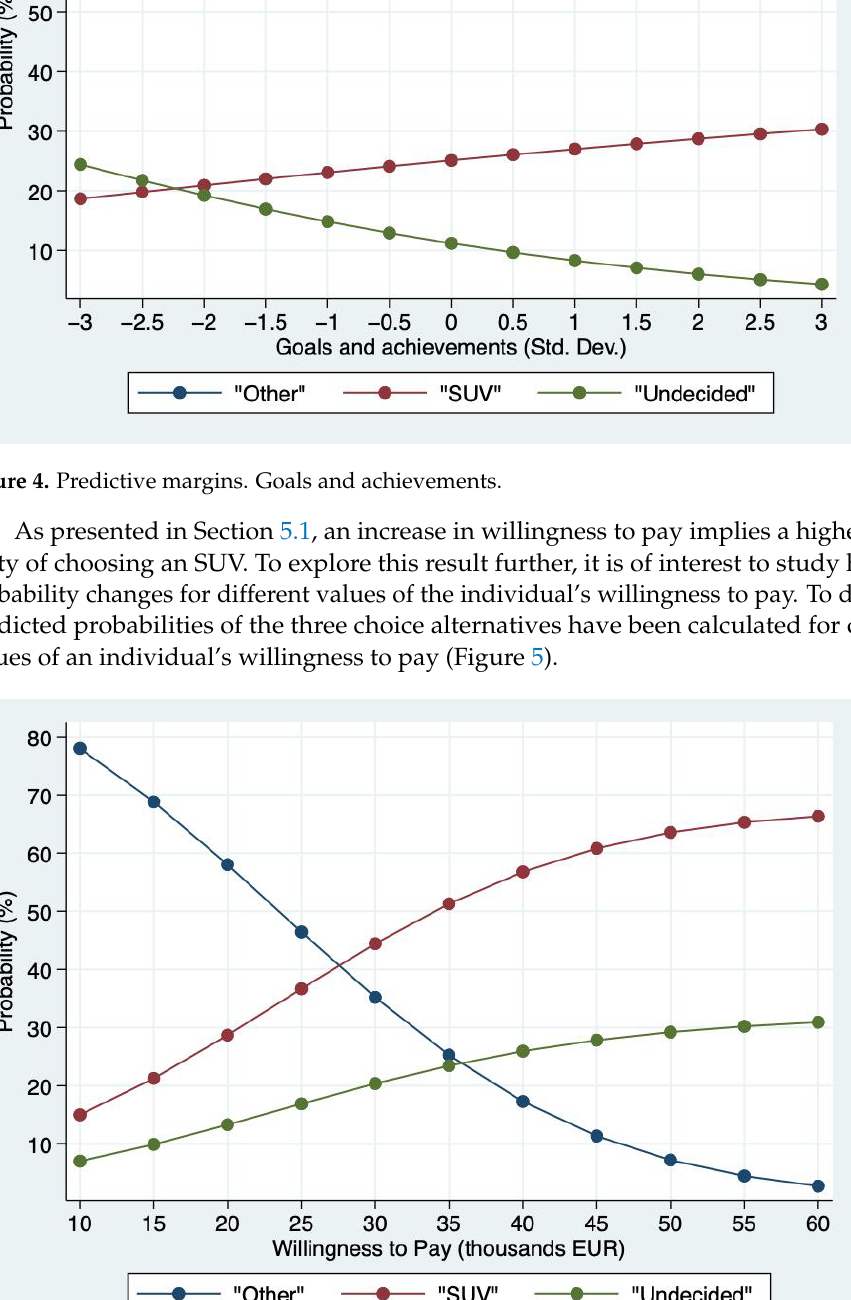
Figure 3. Predictive margins. Environmental awareness.